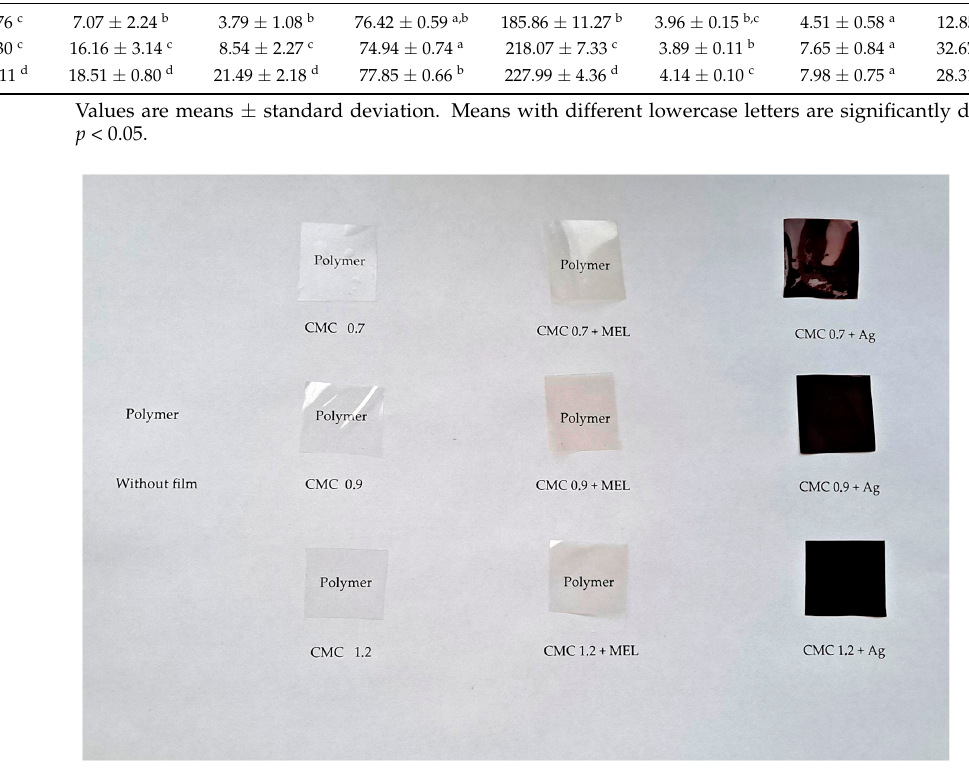
Figure 7 . The visual appearance of neat and modified CMC films. Figure 7. The visual appearance of neat and modified CMC films.